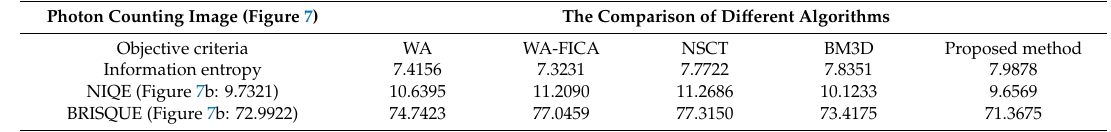
Table 2. Comparison of di ff erent algorithms’ denoising e ff ects from Figure 7. Photon Counting Image (Figure 7)